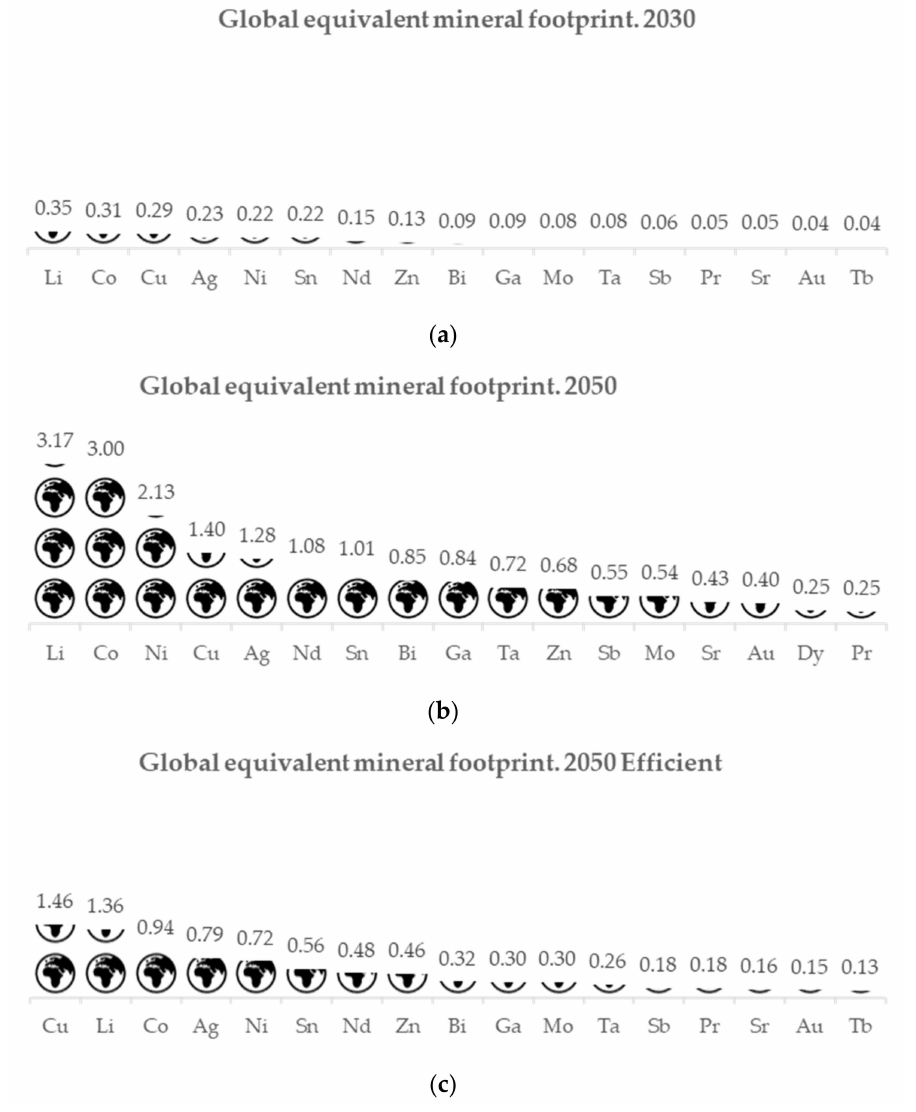
Figure 11. Global equivalent mineral reserves footprint. ( a ) 2030 Scenario; ( b ) 2050 Scenario; ( c ) 2050 Efficient